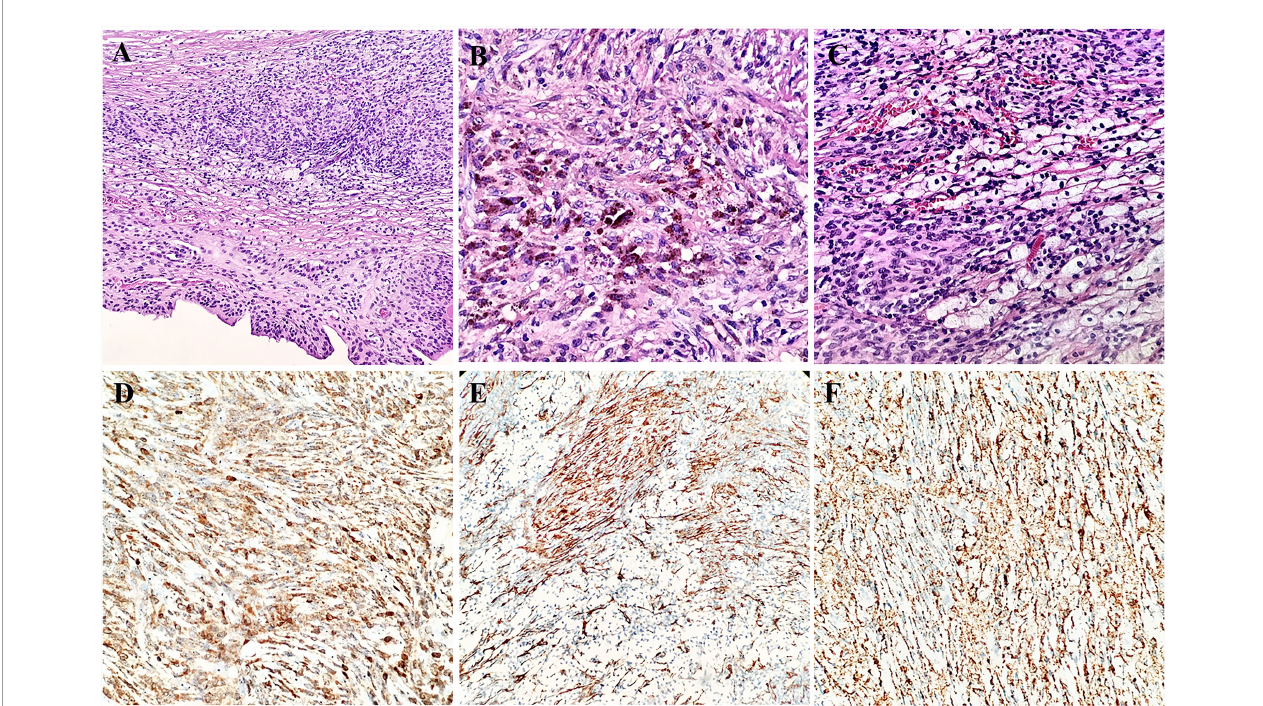
FIGURE 3 | Morphology and immunohistochemistry features of the synovial metaplasia and giant cell tumor of tendon sheath (A) . Hemosiderin granule deposition in the lesion (B) . Nest-like distribution of xanthomatous cells among monocytes (C) . Immunoreactivity for Bcl-2 (D) , SMA (E) , and CD68 (F) in synovium-like cells, mononuclear cells, and osteoclast-like giant